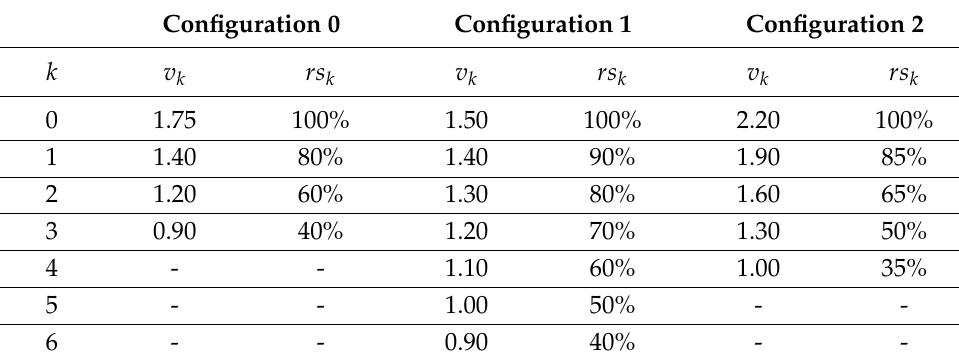
Table 1. Machine